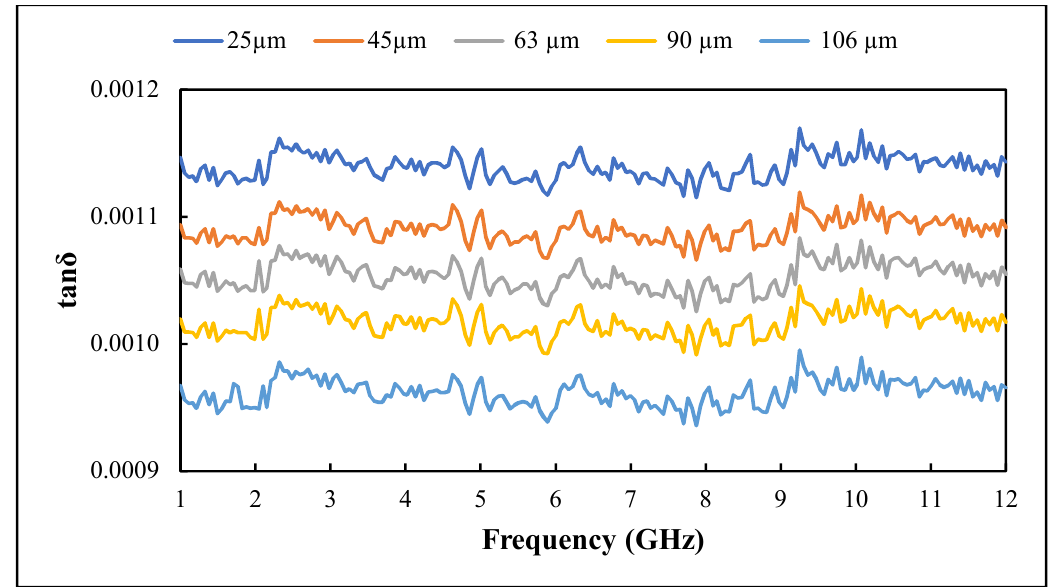
Figure 11. Variation of loss tangent with filler size.